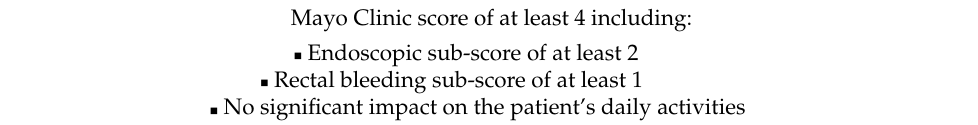
Table 2. Proposal for a definition of mild to moderate ulcerative colitis for clinical trials. Mayo Clinic score of at least 4 including: